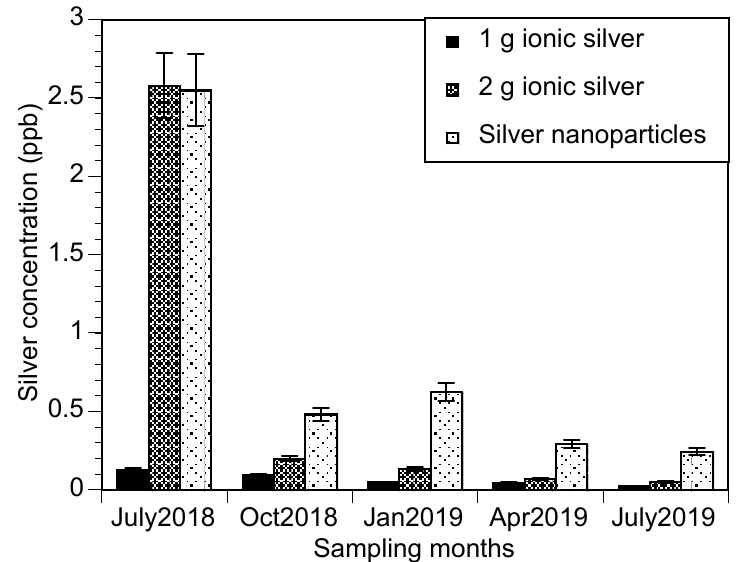
Figure 8. Results of experiments showing silver concentration in effluent over a 13 month period (n = 42).